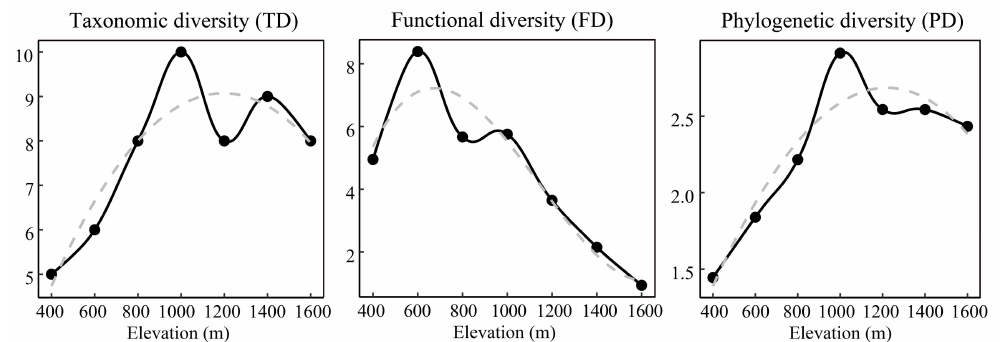
Figure 3. Elevational patterns of small mammal taxonomic diversity (TD), functional diversity (FD), phylogenetic diversity (PD) along a 1400 m elevational gradient in Qingliang Mountain, Anhui, China. The gray dashed line represents the best-fit line.